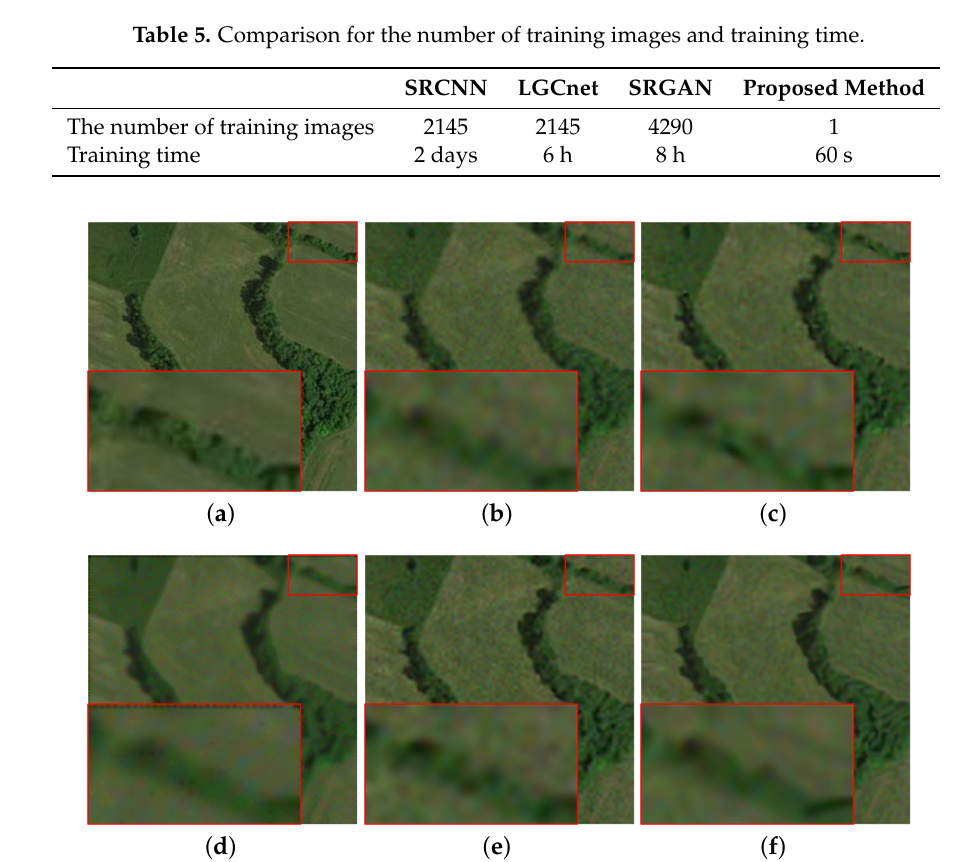
Figure 7. The reconstruction for the meadow of noisy image with different methods (noise = 5). ( a ) original image. ( b ) bicubic interpolation (PSNR:32.19, SSIM:0.7914, ERGAS:2.6744). ( c )